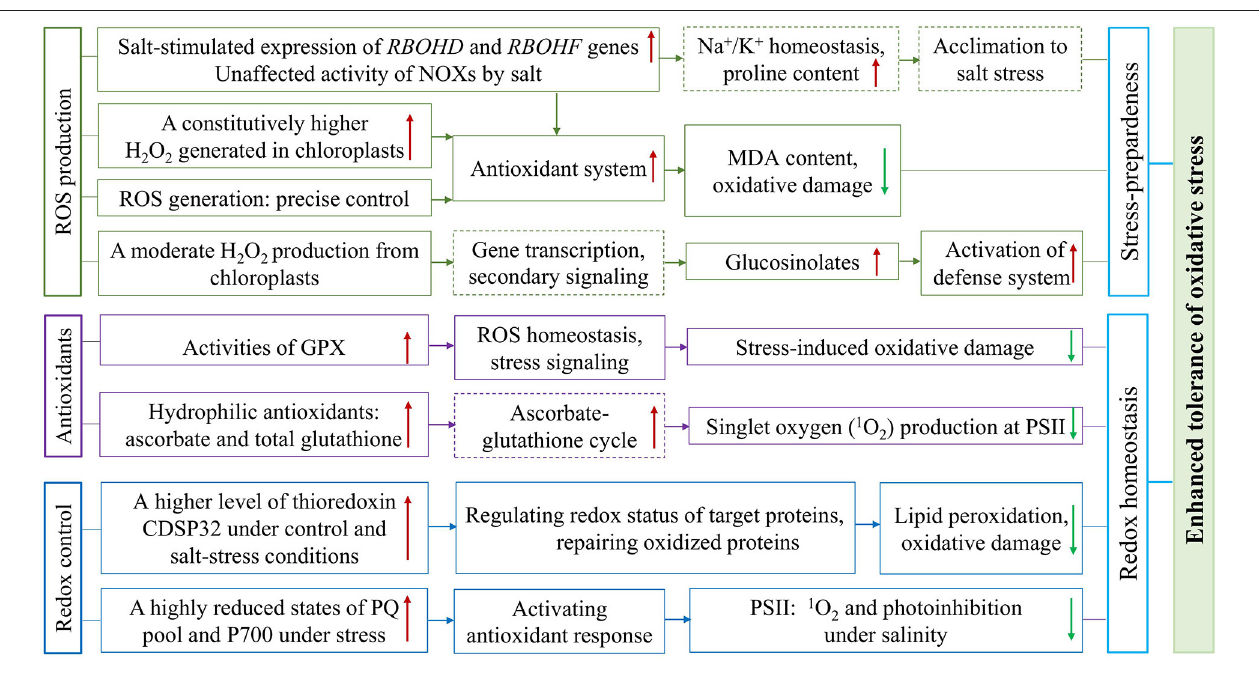
FIGURE 4 | Overview of the constitutively higher expressed antioxidative protection system and effective regulation of redox status in halophytic Eutrema . The plasma membrane ROS produced through NADPH oxidases (NOXs), the important components of signal transduction, encoded by RBOHD and RBOHF genes, is associated with the regulation of Na + /K + homeostasis and increased accumulation of proline involved in salt tolerance. The enhanced antioxidant tolerance of Eutrema is associated with: (1) A constitutively enhanced H 2 O 2 generated to keep the antioxidant system up-regulated to preadapted plant to salinity stress, as well as a chloroplastic production of H 2 O 2 inducing the accumulation of glucosinolates to activate the stress defense system, (2) Antioxidative enzymes such as GPX, and non-enzymatic antioxidants such as ascorbate and glutathione facilitating ROS homeostasis and alleviating damage of singlet oxygen ( 1 O 2 ) to PSII under salt stress, (3) A higher expression level of thioredoxin CDSP32 regulating redox status of target proteins and highly reduced states of PQ pool and P700 facilitating redox homeostasis and lower photoinhibition under salt stress. NOXs, NADPH oxidases; GPX, glutathione peroxidases; PSII, photosystem II; PQ,